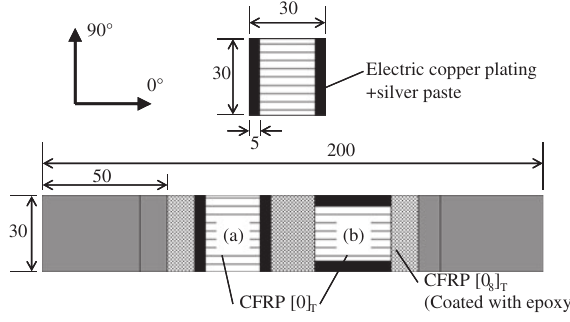
Figure 1 Confi gurations of specimens (a) and (b).